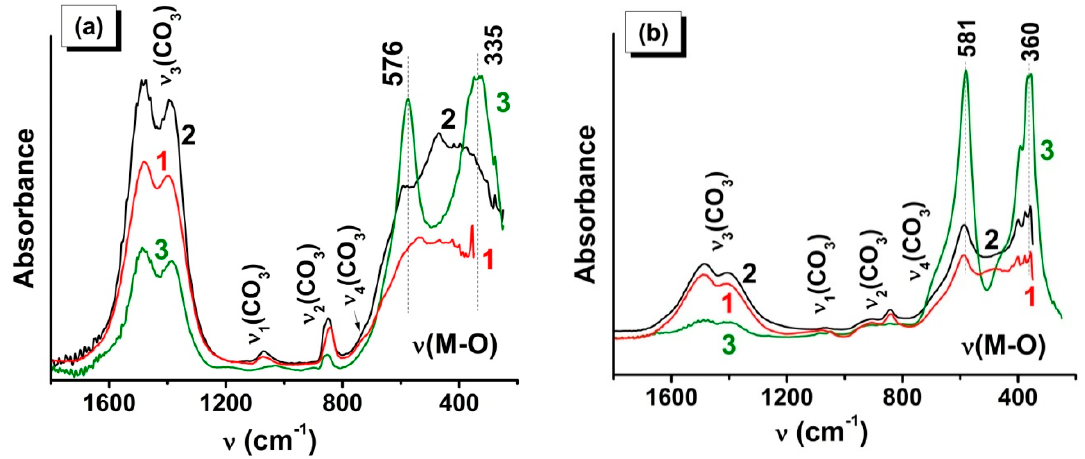
Figure 5. ATR FTIR spectra of combustion products of ( a ) LaMn and ( b ) LaCr precursor for the following regimes: (1) SCS (from solution), (2) VCS (from powder), and (3) SHS (from pellet).